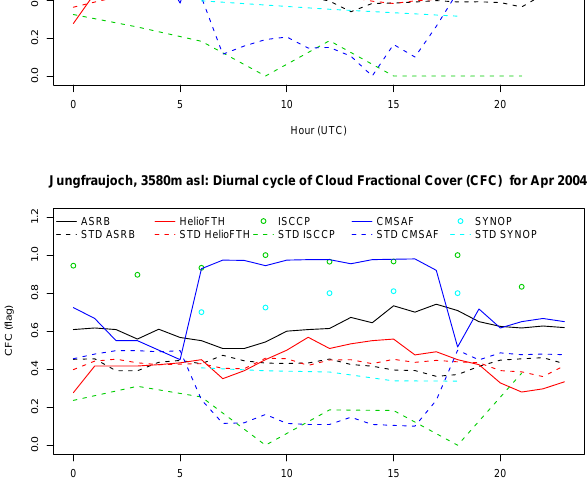
Fig. 1. Flow chart of HelioFTH processing scheme.